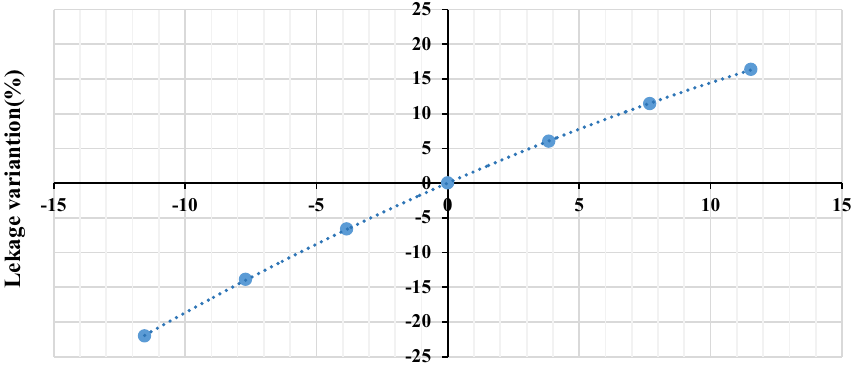
Fig. 8 Variation in network total leakage versus Hazen–Williams coefficient for three-loop Hanoi